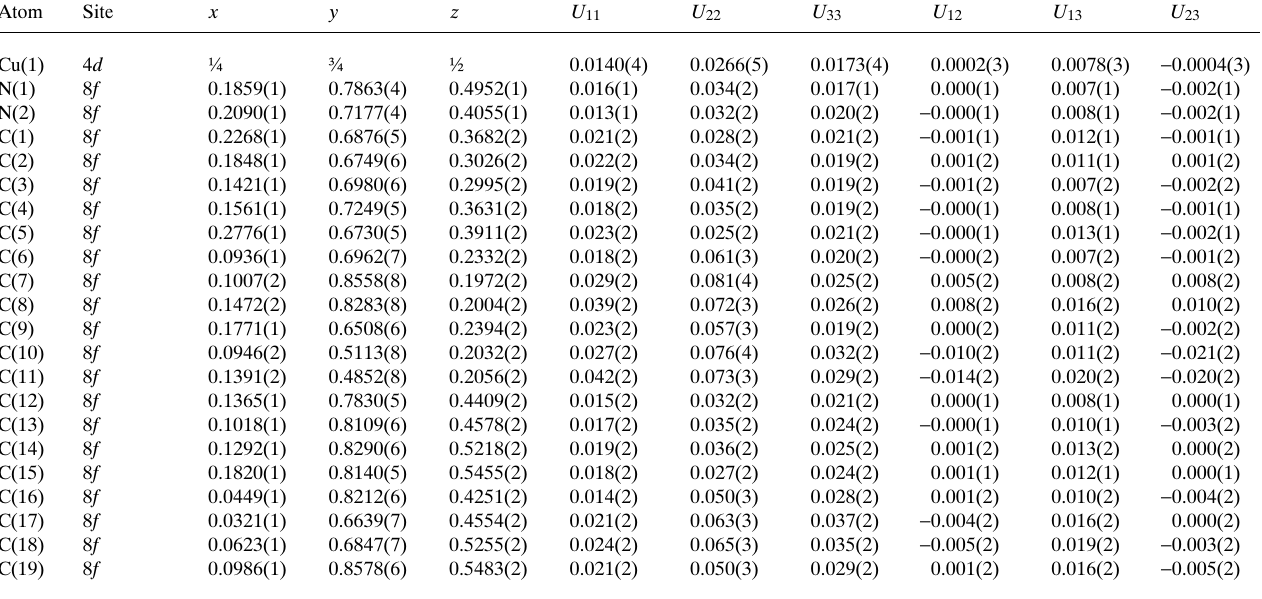
Table 3. Atomic coordinates and displacement parameters (in Å 2 ) .